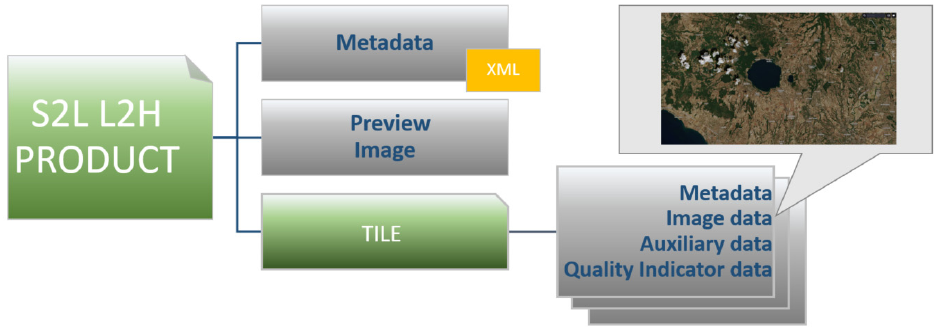
Figure A1. Illustration of the Level 2H product physical format (similar to L2F).